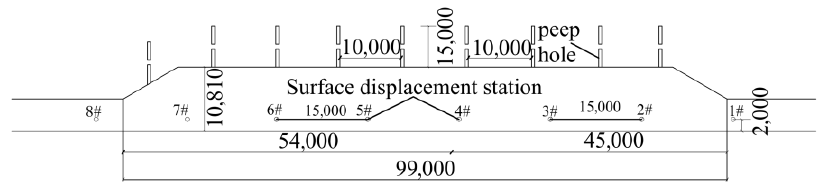
Figure 16. Layout of surface displacement measuring points and peep holes.